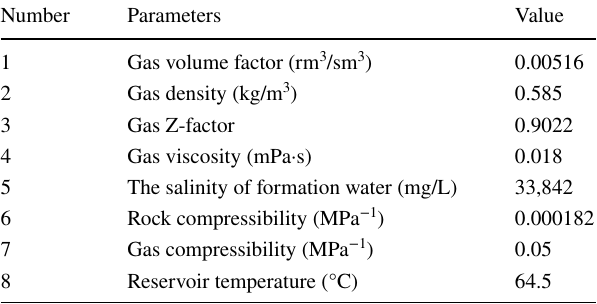
Table 1 Input parameters of the simulation model